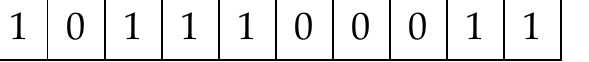
Figure A1. Binary representation of a portfolio in the decision variable space.